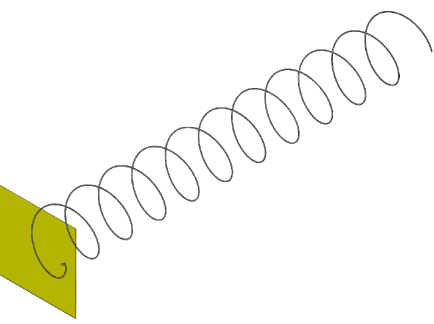
Figure 3. Model with infinite GP.